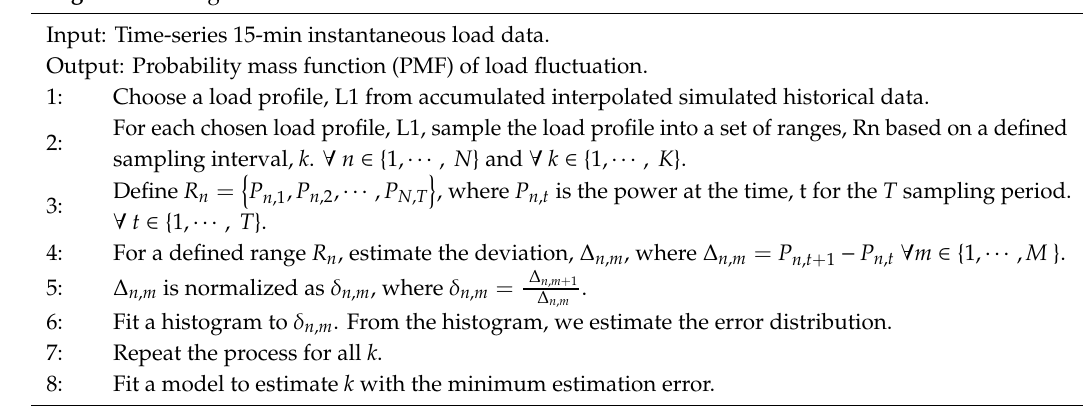
Algorithm 1 details the procedure for the modelling process. Algorithm 1: Algorithm for the load fluctuation model. Algorithm 1: Algorithm for the load fluctuation